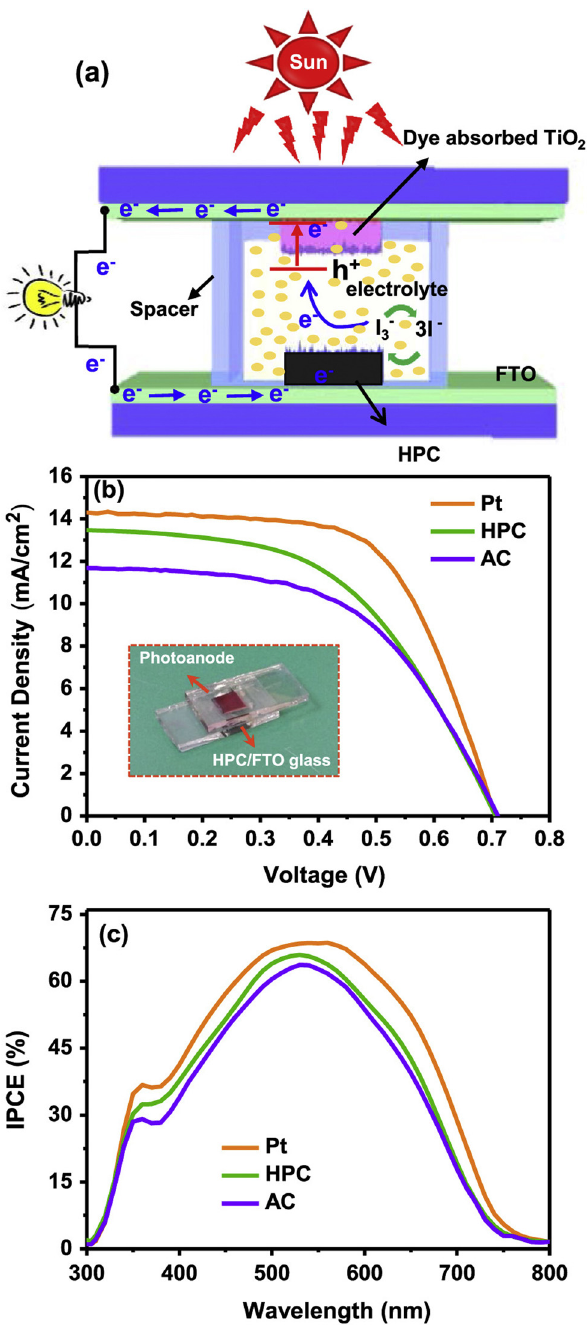
Figure 45: ( a ) Schematic of a DSSC applying HPC as the CE with corresponding ( b ) J – V curves and ( c ) incident photon - to - current e ffi ciency ( IPCE ) spectra ( with a TiO 2 NP photoanode and reference Pt ) . Copied with permission from ref. [ 39 ] ; Elsevier,